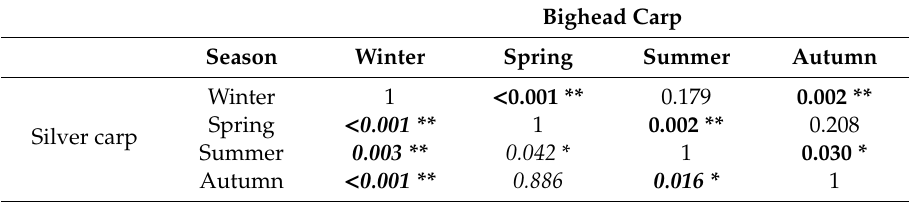
Note: Upper right corner represents bighead carp, and bottom left in italics represents silver carp. Significant e ff ects are indicated in bold. Asterisks denote highly significant, with p < 0.01 (**) and significance, with 0.01 < p < 0.05